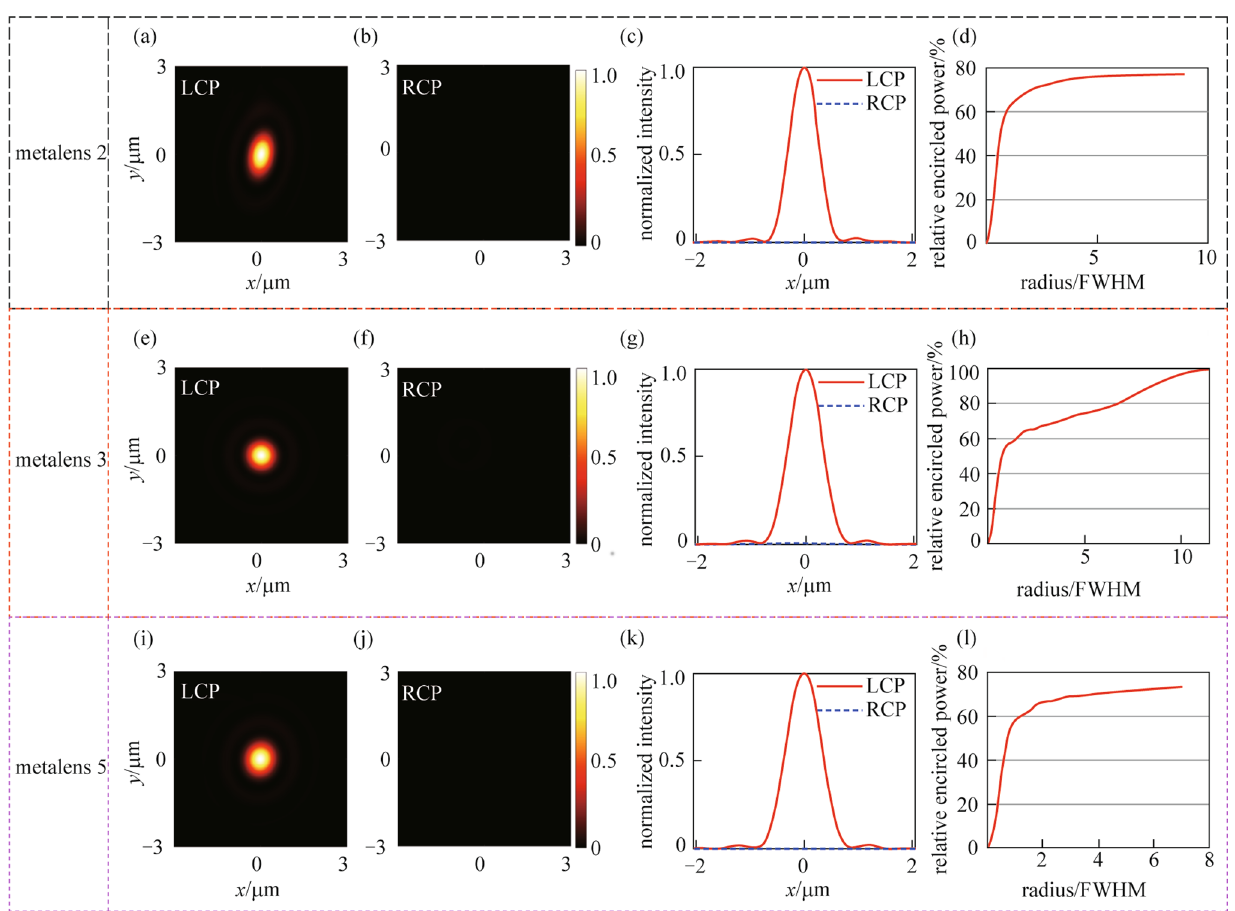
Characterizations of the individual metalens 2, 3, and 5 for the LCP plane wave. a , e , and i Normalized intensity distributions at the focal plane under the LCP incidence. b , f , and j Normalized intensity distributions at the focal plane under the RCP incidence. c , g , and k Nor- malized intensity distributions along the x -axis at the focal plane. d , h , and l Relative encircled efficiency vs. relative radius of the focused